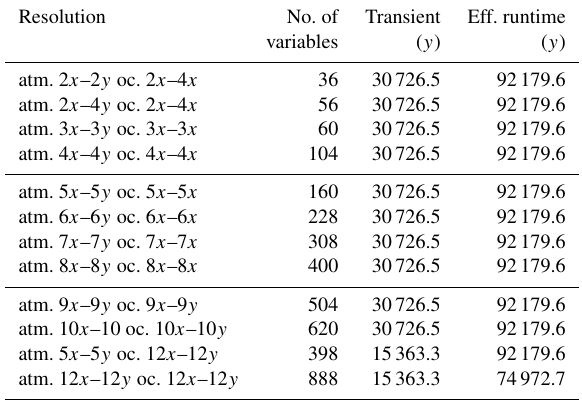
Table 2. Number of variables, transient time, and effective runtime of the runs (in years).